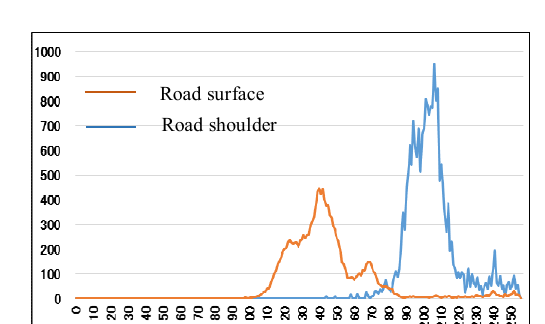
Table 4. Average